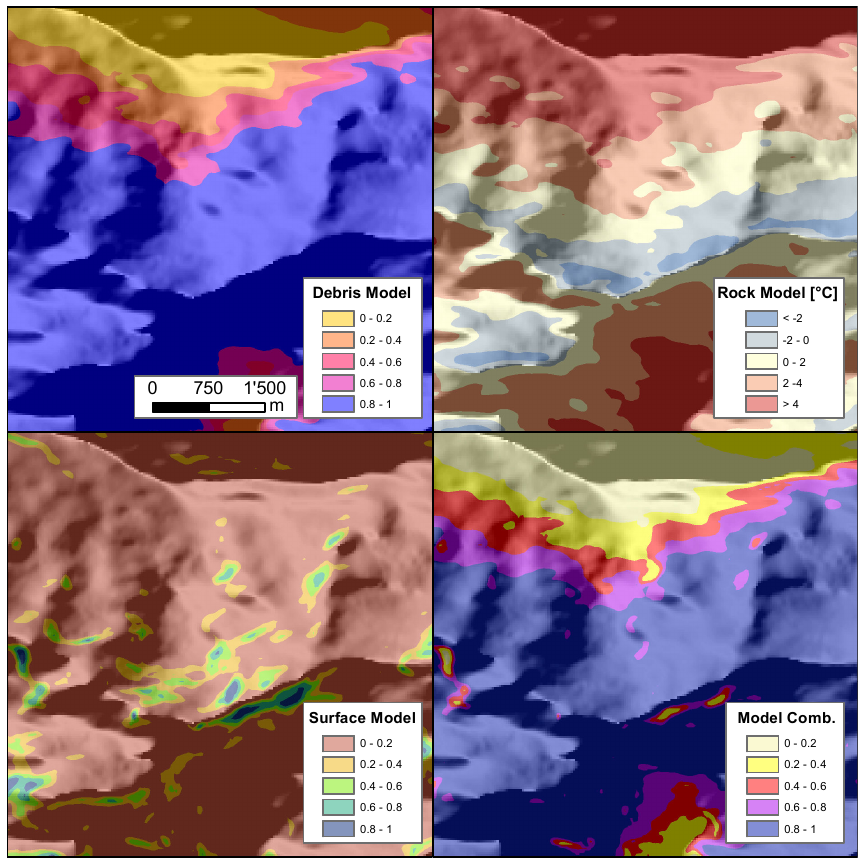
Fig. 5. Example of the application of the different models. Top left: Prediction of the debris model showing probabilities of permafrost occurrence. Top right: Predicted MARST values of the rock model. Bottom left: Prediction of an arbitrary surface model (here: probabilities of steep bedrock occurrence depending on slope angle only). Bottom right: Combination of the three models showing probabilities of permafrost occurrence.